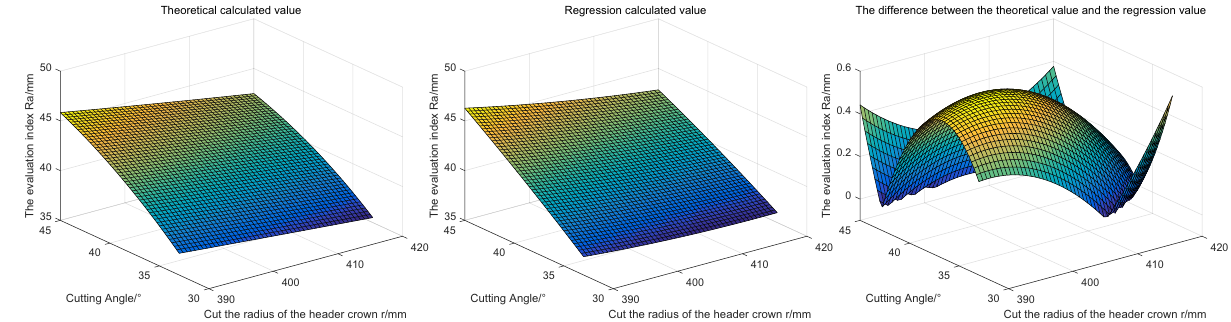
Figure 11. The influence of different cutting angles and the radius of cutting head crown on the evaluation index.